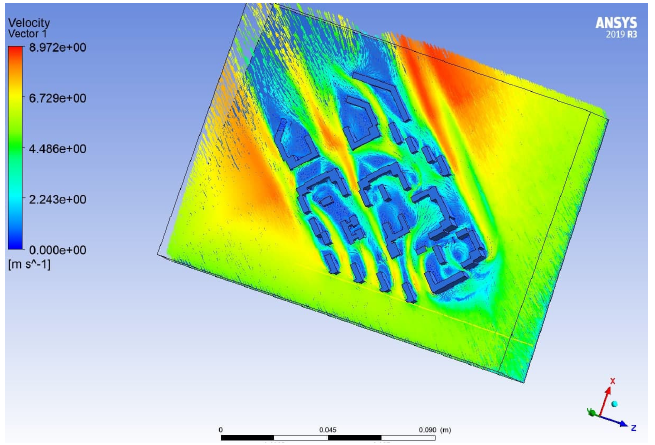
Figure 22. Velocity isofields obtained as a result of simulation, Level 1.